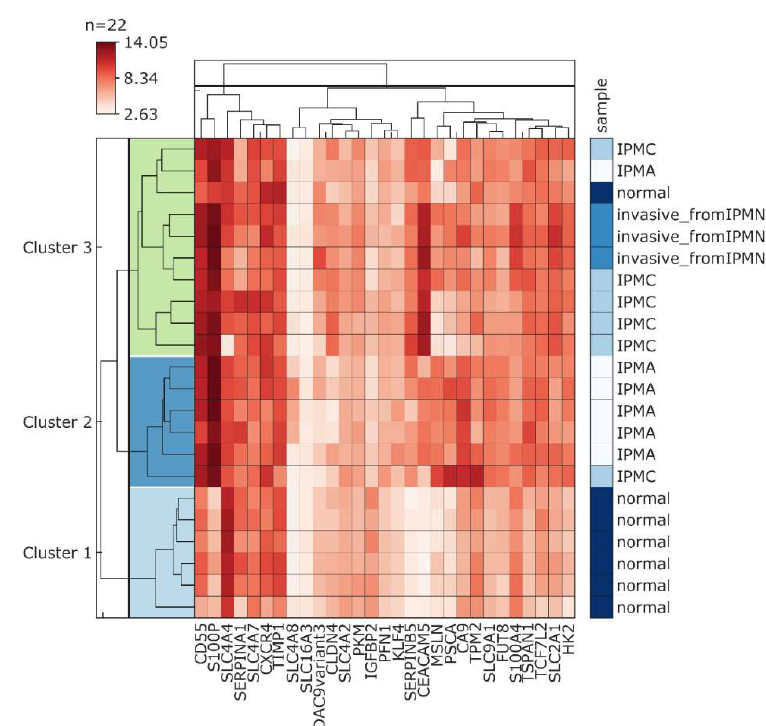
Figure 7. Hierarchical clustering of GSE19650 samples according to the panel of Genes Highly Expressed in IPMNs as Compared with Normal Pancreatic Ductal Epithelium and Genes Associated with Invasive Intraductal Papillary Mucinous Neoplasms of the Pancreas [139] , selected pH regulators (SLC4A7, SLC4A4, SLC4A8, SLC4A2, SLC9A1), and glycolysis-related genes (HK2). Genes from the panel of Sato et al. (2004) as well as CA9 show a mutual correlation and a differential expression between normal healthy samples and IPMN samples. Hierarchical cluster analysis was able to correctly cluster the majority of normal healthy tissue samples into one cluster and all mucinous neoplasm samples were grouped into two clusters: cluster 2 contains mainly non-invasive adenoma samples, while cluster 3 includes the majority of adenocarcinoma with invasion and invasive carcinoma.